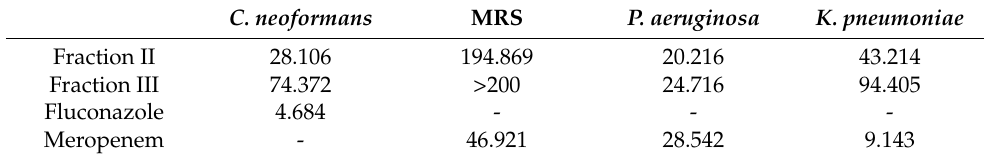
Table 1. IC 50 ( µ g/mL) of the antimicrobial activity of fractions of P. officinalis . C.